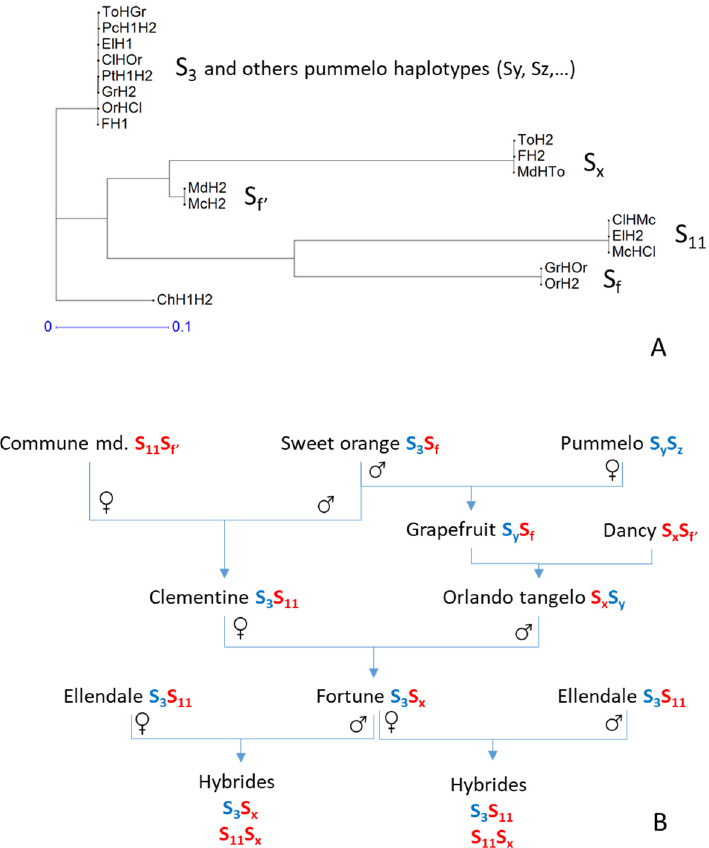
Figure 7. Analysis of potential SI haplotypes according to the flanking sequences of the SI locus and published SI alleles from cross compatibility analysis (Kim et al., 2020) [38]. ( A ): Neighbor-joining analysis of haplotypes for markers located after the recombination event in the ‘Fortune’ FH1 maternal gamete; ( B ): proposed inheritance of the SI alleles in the related varieties and hybrids analyzed. Blue represents C. maxima and red represents C. reticulata haplotype ancestry, according to Oueslati et al. (2017).